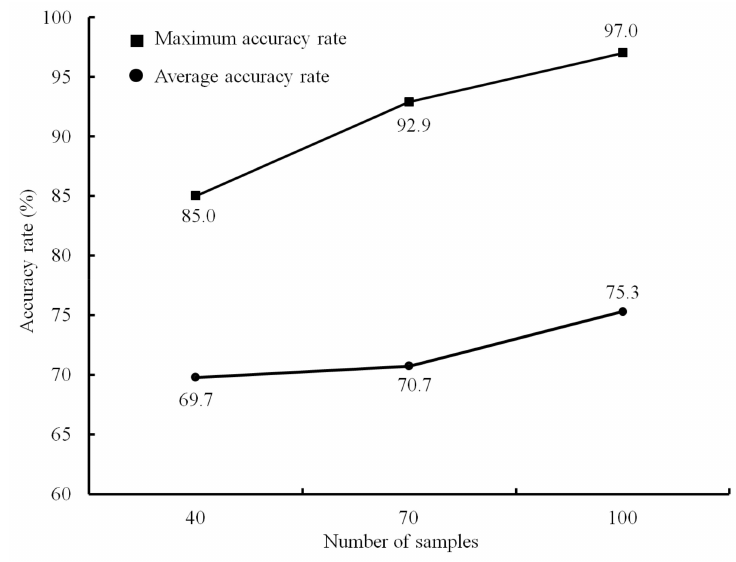
Figure 5. Model accuracy rate under different sample